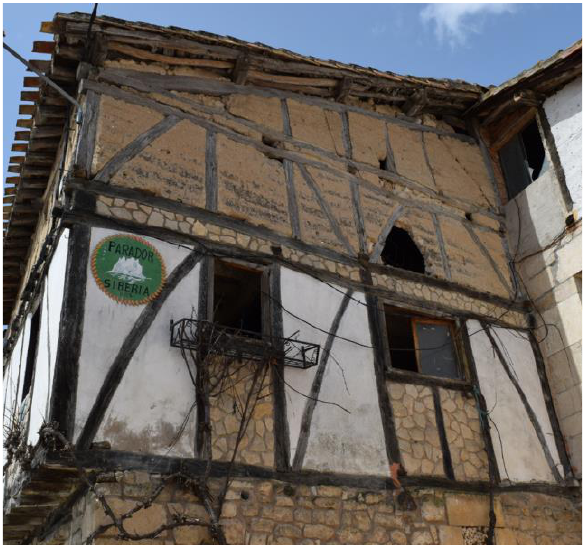
Figure 11. Building in Valdazo (Burgos), aesthetically updated with mortar